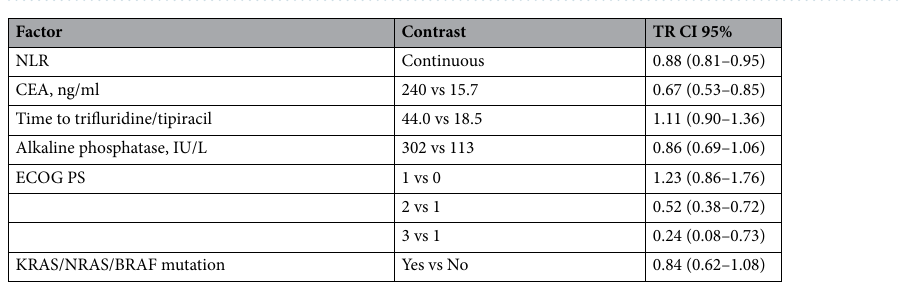
Table 2. Contrasts of the AFT model lognormal for overall survival. AFT, accelerated failure time; NLR, Neutrophil–lymphocyte ratio; ECOG-PS, Eastern Cooperative Oncology Group Performance Status; sd, standard deviation; TR, time ratio; CI, confidence